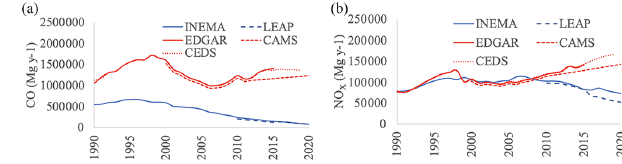
Figure 10. Comparison between CO (a) and NO x (b) between this work (INEMA) and other local and global emission inventories.